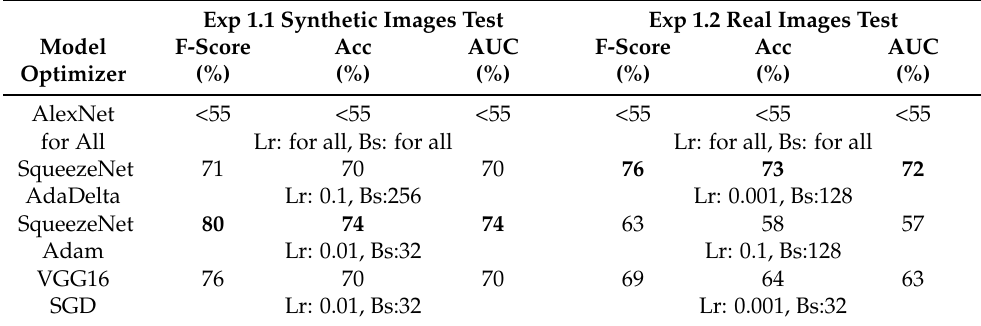
Figure 8. Schematic representation of combinations of networks. Table 2. Experiment 1: Deep learning-based networks’ F-score, accuracy (Acc), and AUC values of the test results. It shows the test success of networks trained without using the CDNTS layer. Values that styled bold represent the most successful test listed. Lr: Learning Rate, Bs: Batch Size.